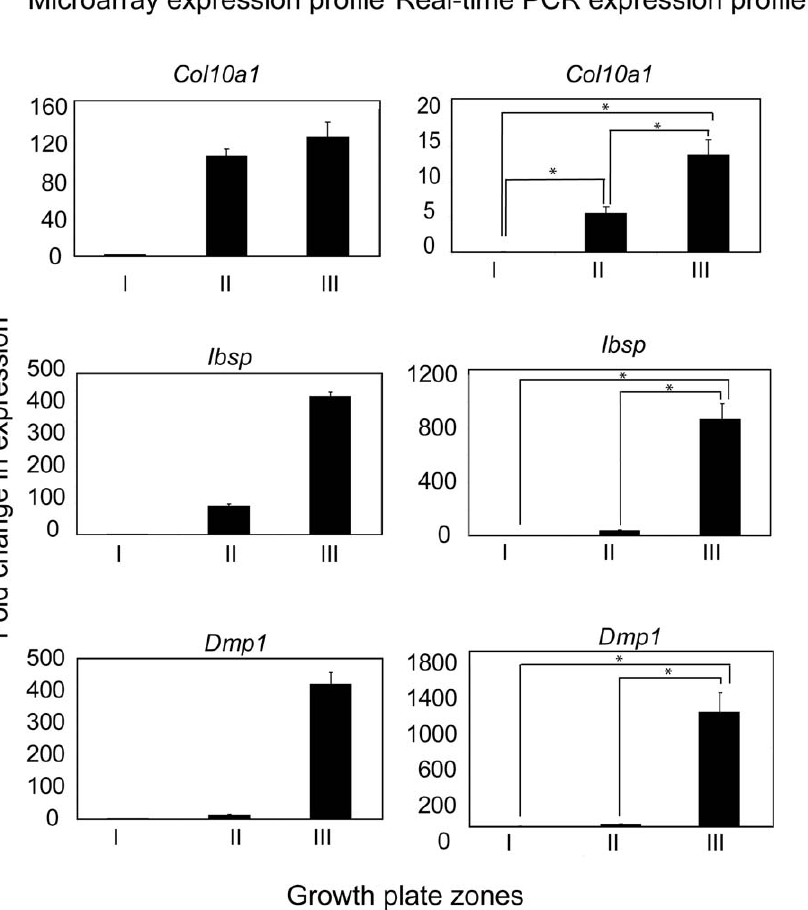
Figure 3. Real-time RT-PCR confirmation of later-stage markers of endochondral ossification. RNA samples from microdissected embryonic tibiae were used to confirm microarray expression profiles for later-stage chondrocyte markers. Collagen X ( Col10a1 ), bone sialoprotein ( Ibsp ) and dentin matrix protein 1 ( Dmp1 ) were identified in the microdissected array and validated with qRT-PCR. Four independent RNA isolations were evaluated for each probe and primer pair and p-values less than 0.05 were deemed significant.